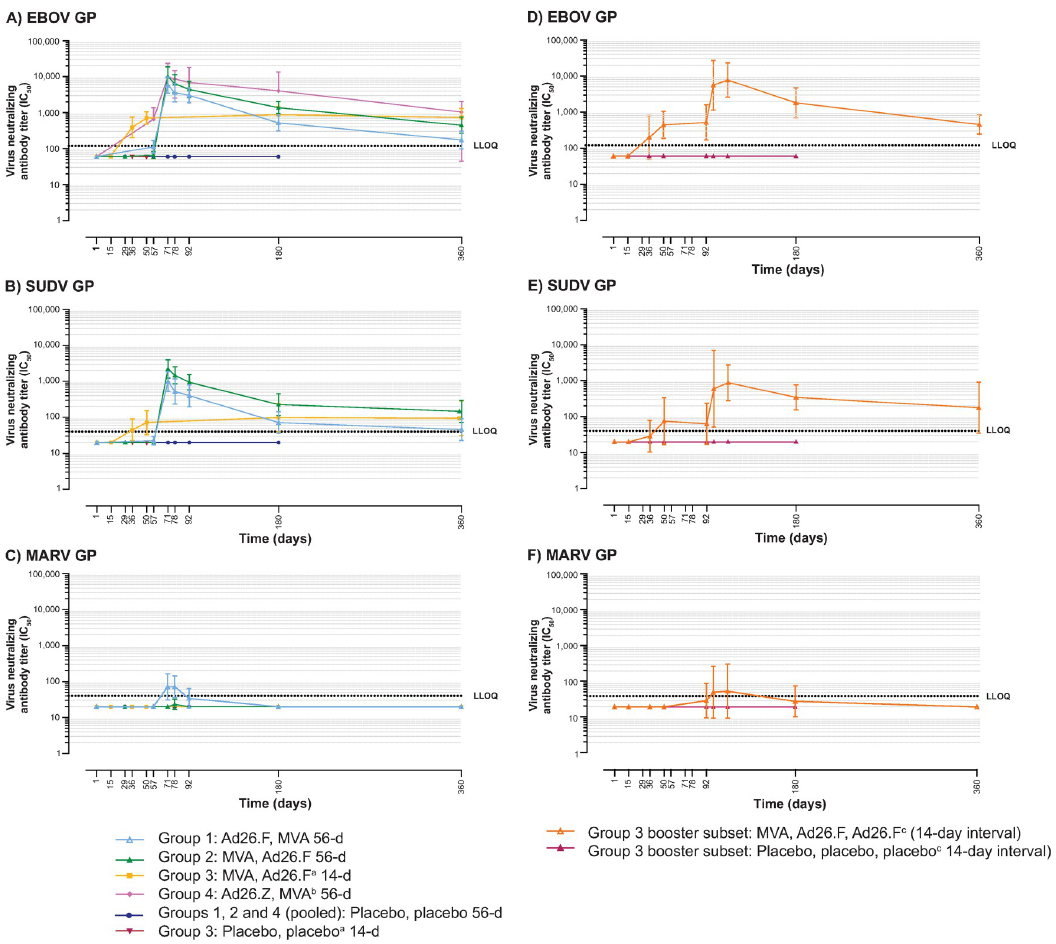
Fig 3. GP-specific neutralizing antibody responses (psVNA); immunogenicity analysis set. Ad26.F = Ad26.Filo; Ad26.Z = Ad26. ZEBOV; EBOV = Zaire ebolavirus ; GP = glycoprotein; IC 50 = 50% inhibitory concentration; Inf U = infectious units; LLOQ = lower limit of quantification; MARV = Marburg virus ; MVA = MVA-BN-Filo; psVNA = pseudovirion neutralization assay; SUDV = Sudan ebolavirus . a Includes all Group 3 participants up to and including the Day 50 time point, after which point only Group 3 participants who did not receive a third dose of vaccine/placebo on Day 92 are included. b MVA-BN-Filo at a dose 1x10 8 Inf U. c All time points include only Group 3 participants who received three doses of